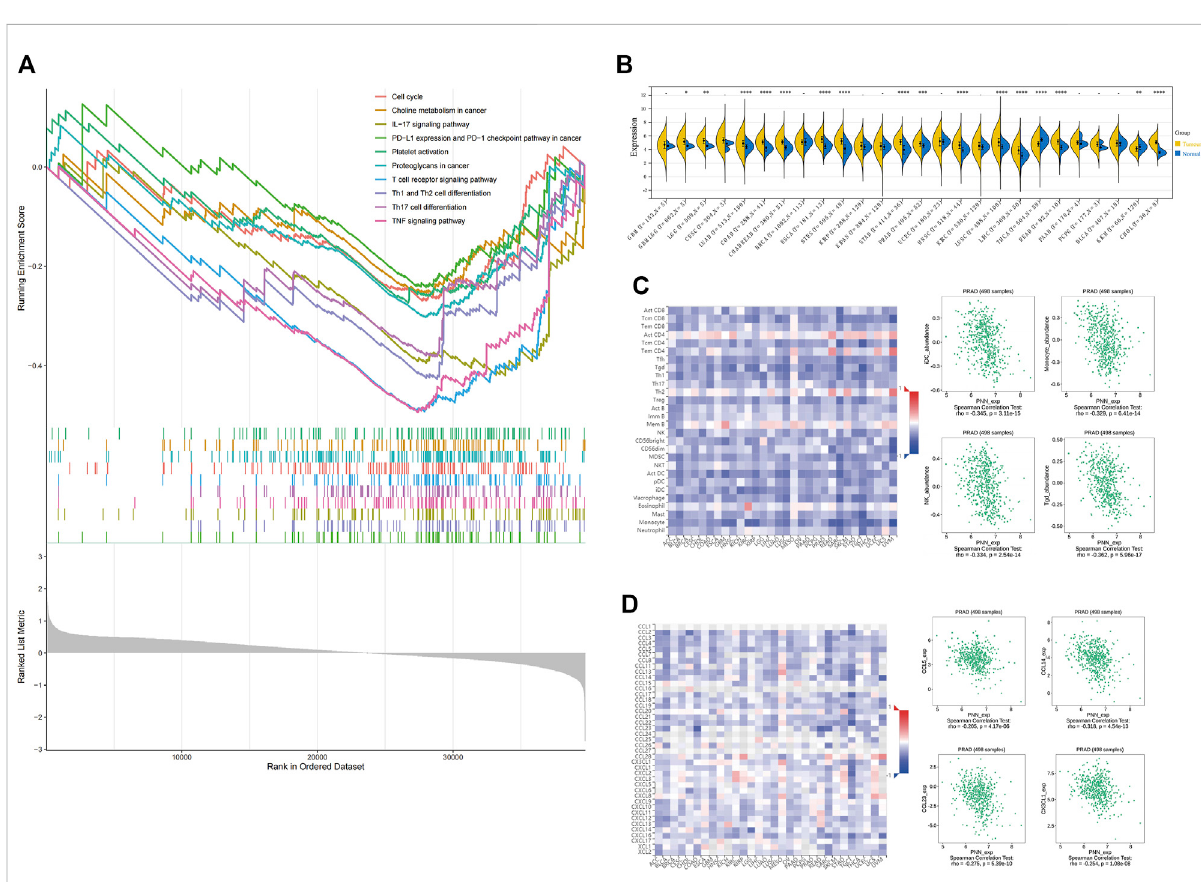
FIGURE 7 Immune in fi ltration. (A) GSEA results are based on PNN high- and low-expression groups. (B) PNN expression pro fi le in pan-cancers. Unpaired Wilcoxon Rank Sum and Signed Rank Tests for signi fi cance of differences analysis. Analysis of the correlation between PNN expression and (C) tumor-in fi ltrating lymphocytes (TIL) and (D) chemokines. The left fi gure shows the correlation between PNN expression in TCGA pan-cancer and TIL, immunosuppressants, and chemokines, and the Scatter plot (right) clearly shows correlations with PNN expression in PCa